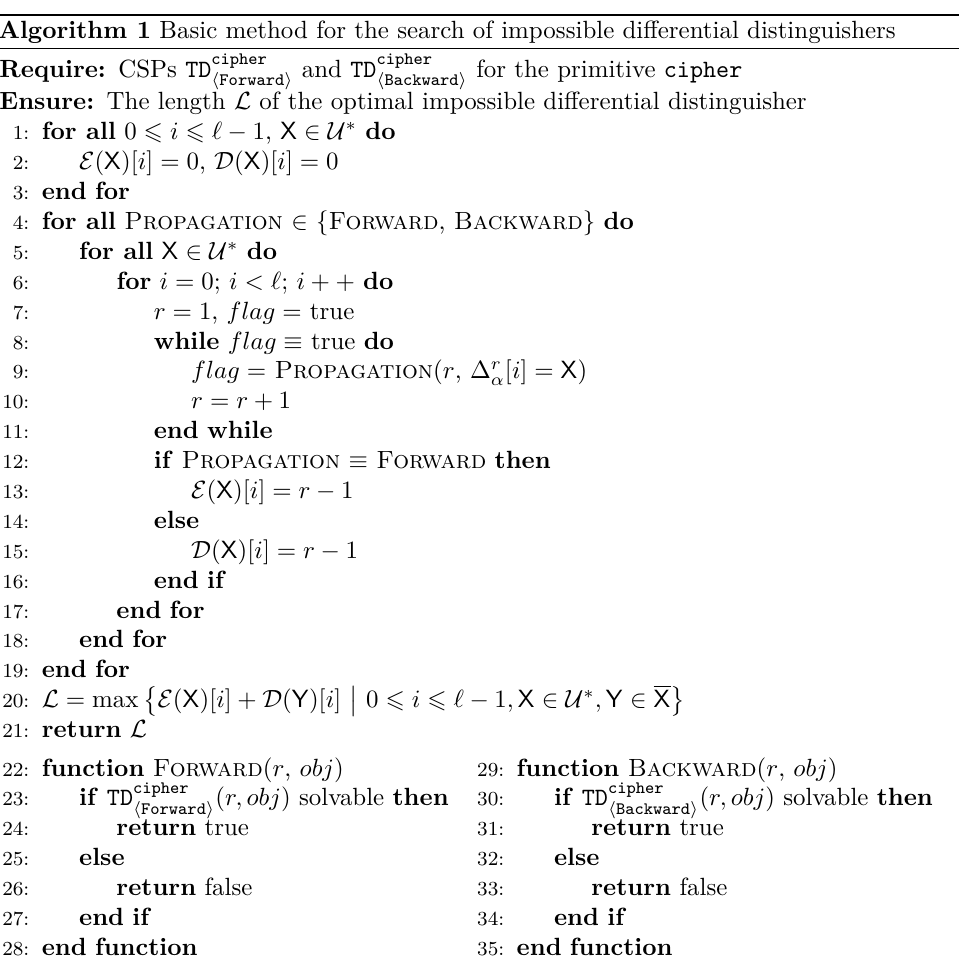
Algorithm 1 Basic method for the search of impossible differential